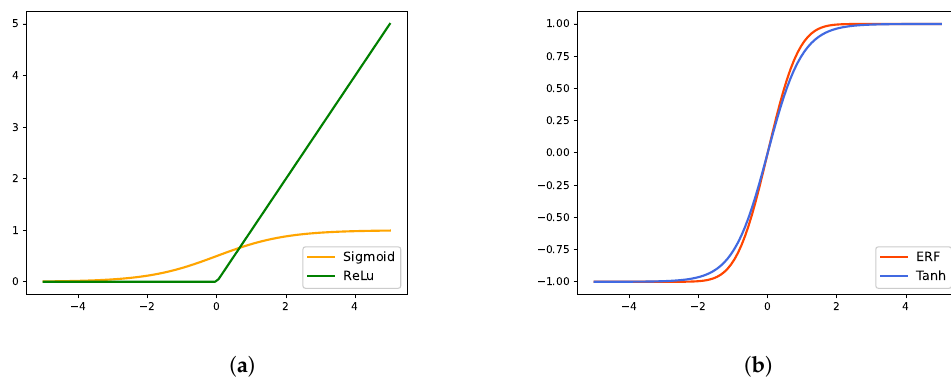
Figure 3. The comparison of activation function. ( a ) Sigmoid and ReLu. ( b ) ERF and Tanh.